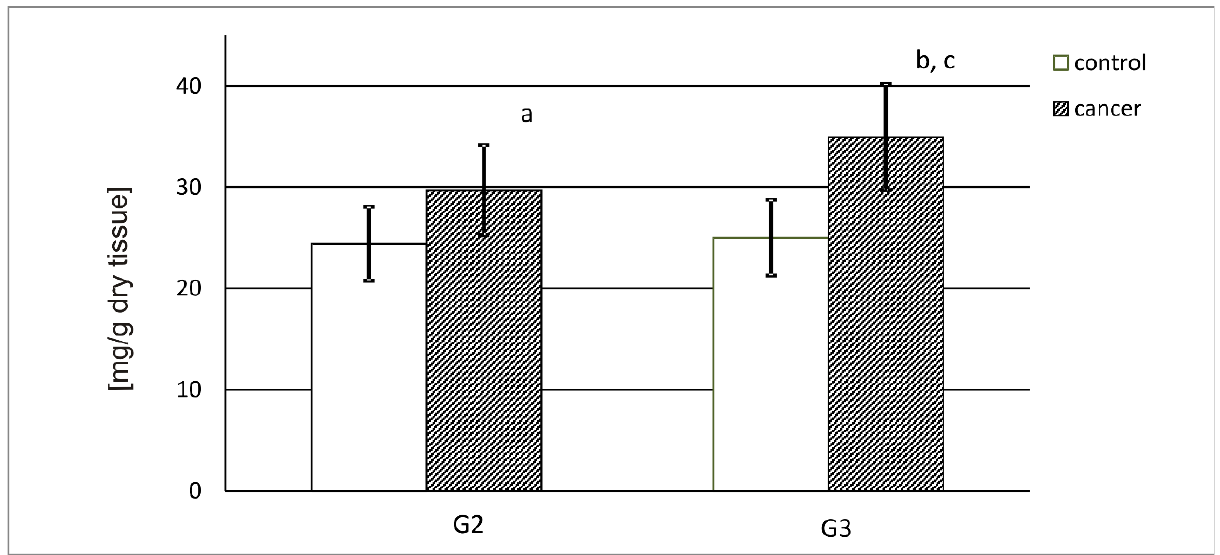
Figure 1. DNA content in control tissue and G2 and G3 (HG) kidney cancer. a — p < 0.05 G2 vs. kidney control b — p < 0.001 G3 vs. kidney tumor c — p < 0.05 G3 vs. G2.